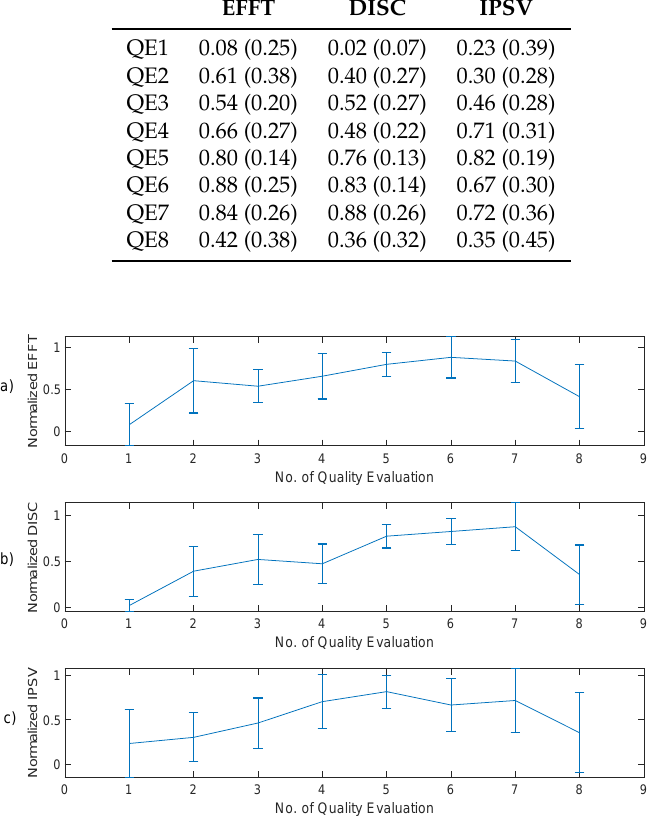
Figure 4. Cross-session variations mean and standard deviation values of SAVRa ratings for all participants (n = 10). ( a ) speaking effort level (EFFT); ( b ) laryngeal discomfort level (DISC); ( c ) inability to produce soft voice